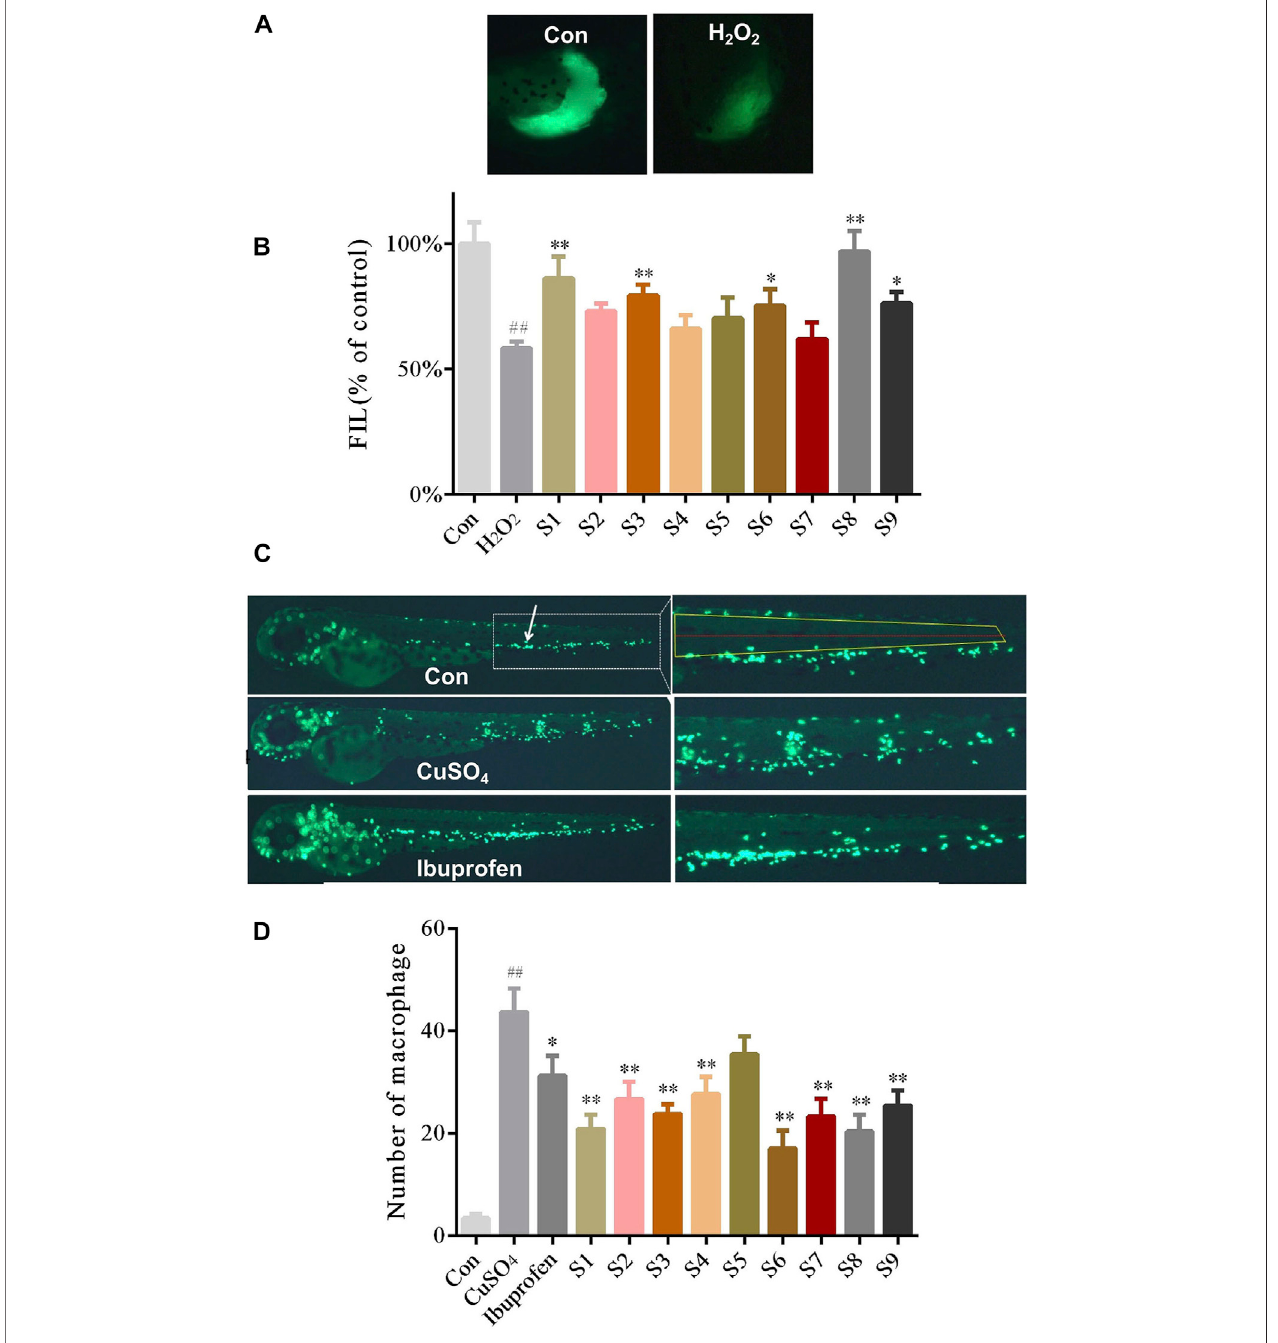
FIGURE 1 | The protective effect of nine samples of GF (S1-S9) collected from different areas on liver injury and in fl ammation (A) Phenotypic micrograph of the transgenic zebra fi sh with fl uorescence label in the liver (B) Statistical results of the fl uorescence intensity of the liver in zebra fi sh until fi ve dpf in all groups. n (cid:2) 10 (C) Distribution phenotypic micrograph of neutrophils (white arrows) in zebra fi sh and enlarged drawing of neutrophils spreading to the lateral neuromast of the tail (D) Statistical results of the number of neutrophils diffusion in zebra fi sh in all groups, n (cid:2) 10.